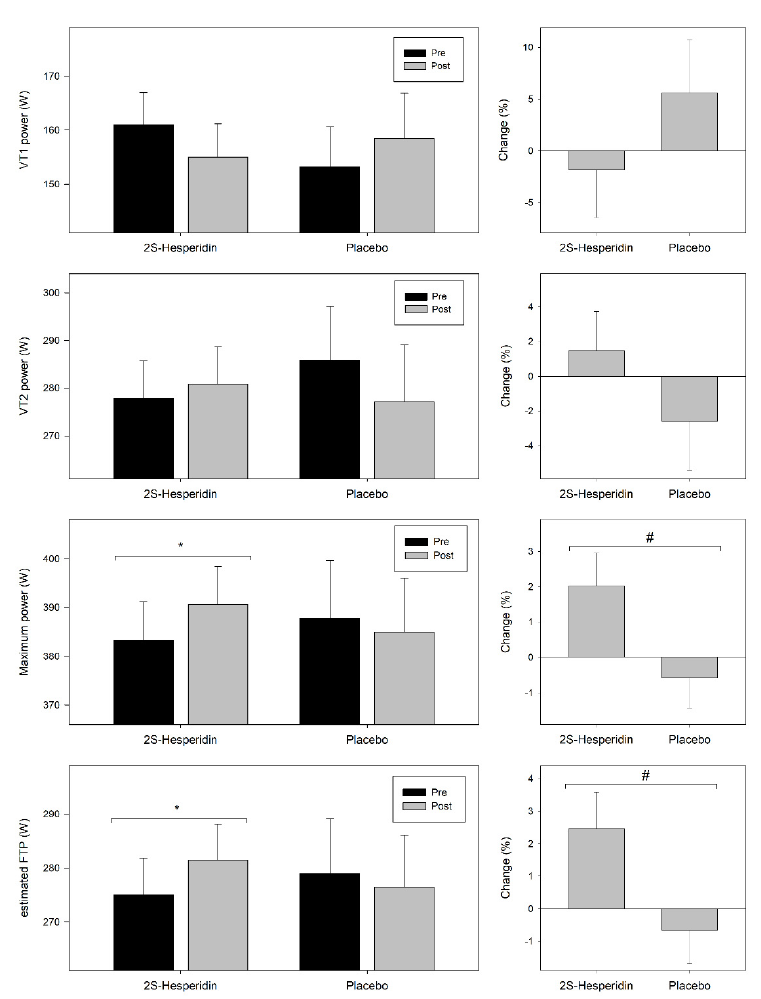
Figure 3. Changes in ventilatory 1 (VT1) power, ventilatory threshold 2 (VT2) power, estimated functional threshold power (FTP) and maximum power during the incremental test. Values are mean ± SE. * Within-group significant changes ( p ≤ 0.05). # Between group significant changes ( p ≤